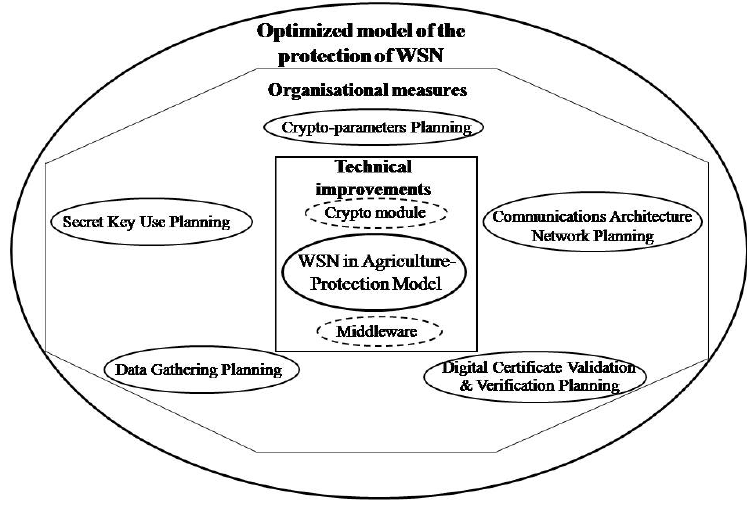
Figure 13. Optimized model of the protection of sensor networks in agriculture.